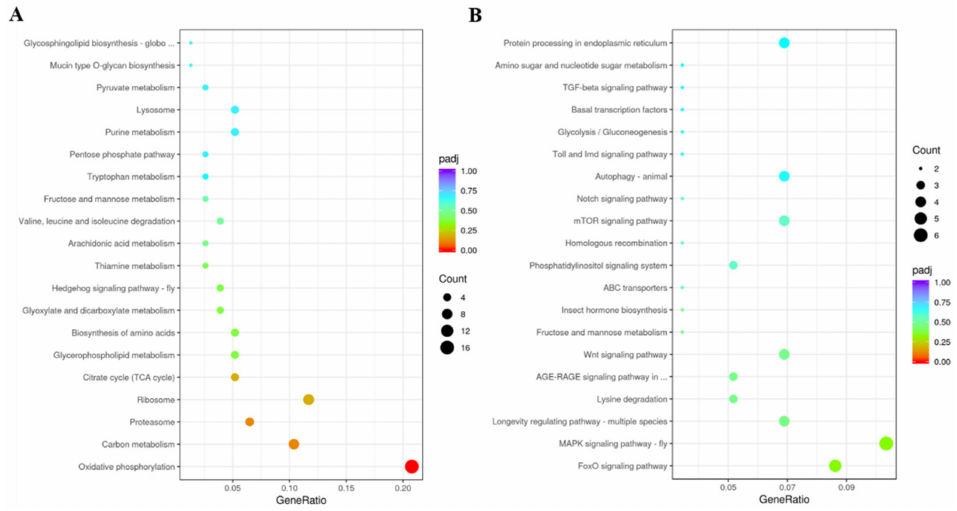
Figure 11. KEGG (Kyoto Encyclopedia of Genes and Genomes) enrichment analysis of DEGs. A scatter diagram of KEGG pathways. The x -axis indicates the gene ratio. The y -axis indicates different pathways. ( A ) Up-regulated DEGs. ( B ) Down-regulated